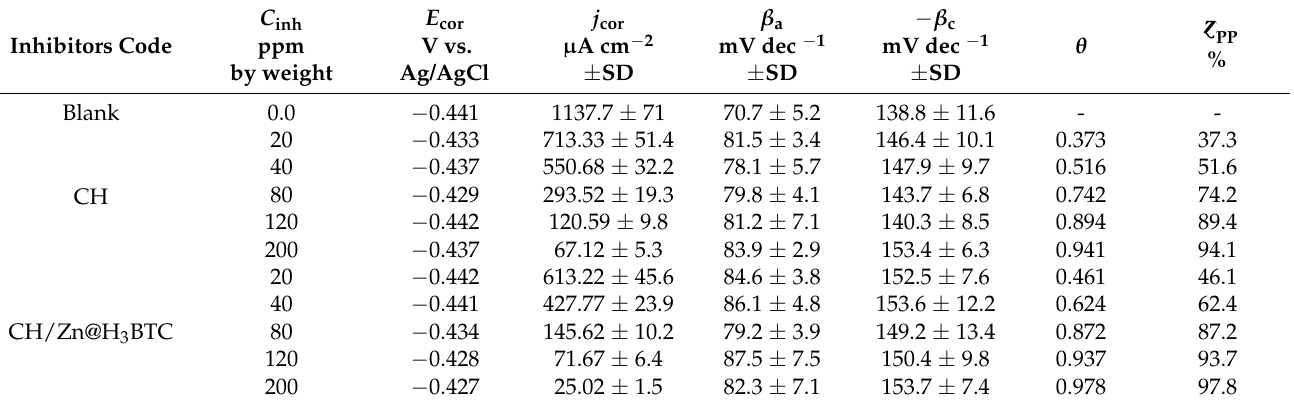
Figure 6. Tafel profiles for duplex steel at 323 K in 2.0 M H 2 SO 4 without and with various concen- trations of ( A ) CH and ( B ) CH/Zn@H 3 BTC. Table 1. PDP parameters achieved for duplex steel in 2.0 M H 2 SO 4 solution in the absence and presence of various concentrations of CH and CH/Zn@H 3 BTC at 50 ◦ C.